Question: Name the type of graph shown.
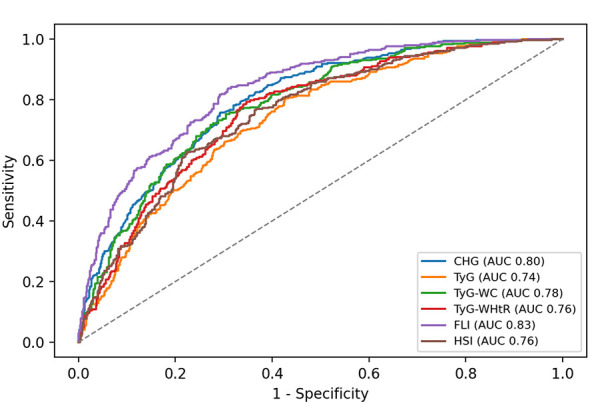
Answer: line